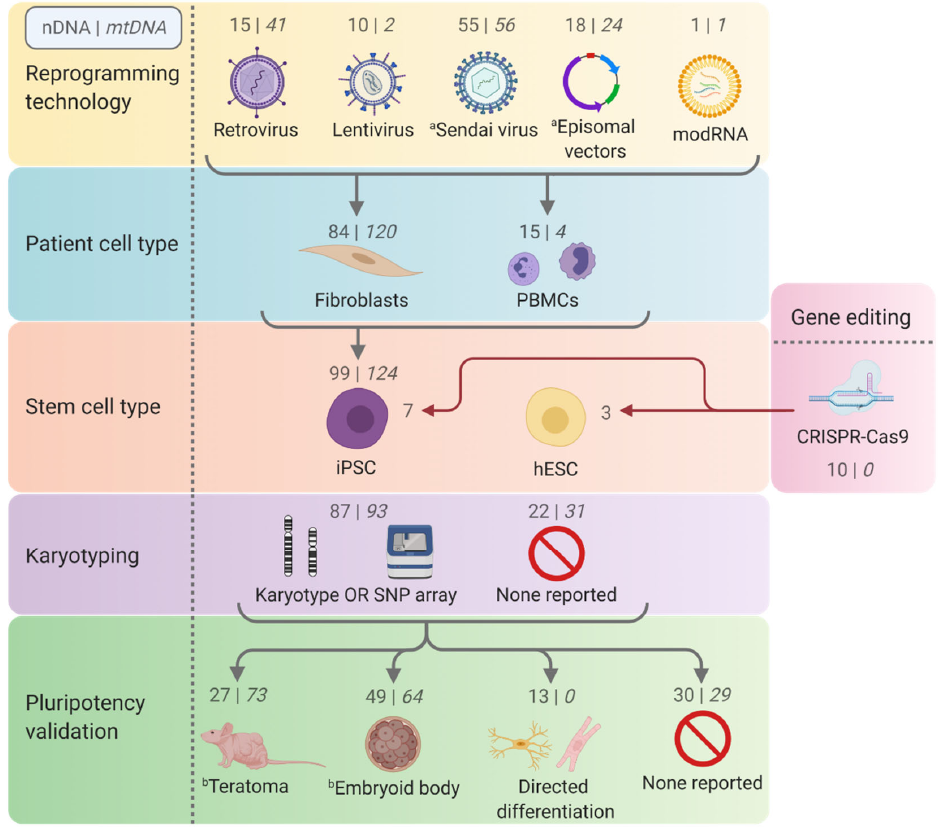
Figure 3. Generation and validation of mitochondrial disease iPSC lines. A graphical illustration of the various pathways used to generate and validate the mitochondrial disease hPSC lines described in Tables A1 and A2, indicating the number of nDNA and mtDNA clones generated from each somatic cell type by the technologies used in the process. The counts include all validated and reported clones generated for each nDNA and mtDNA cell line (with >30% mutant heteroplasmy for mtDNA lines) to highlight the discrepancy in the number of clones often generated and screened for mtDNA lines versus nDNA lines due to variable heteroplasmy following reprogramming. For some nDNA lines, CRISPR ‐ Cas9 gene editing was used to generate mitochondrial disease gene mutations in wild type hPSC backgrounds. Two key steps in the validation of iPSC lines are karyotyping or SNP (single nucleotide polymorphism) array analysis and pluripotency validation. Karyotype analysis minimises the risk that any unanticipated chromosomal rearrangements may have occurred during reprogramming. Pluripotency validation must demonstrate the ability to generate the three germ layers, in addition to the expression of pluripotency markers (e.g., SSEA4, TRA ‐ 1 ‐ 81, TRA ‐ 1 ‐ 61) [75]. a Fibroblasts were used as the patient somatic cell type for all lines except for 10 nDNA and 4 mtDNA mutation clones using Sendai virus and 5 nDNA mutation clones reprogrammed using episomal vectors. b 10 nDNA and 42 mtDNA lines were double counted as they were validated by both teratoma and embryoid body assays.